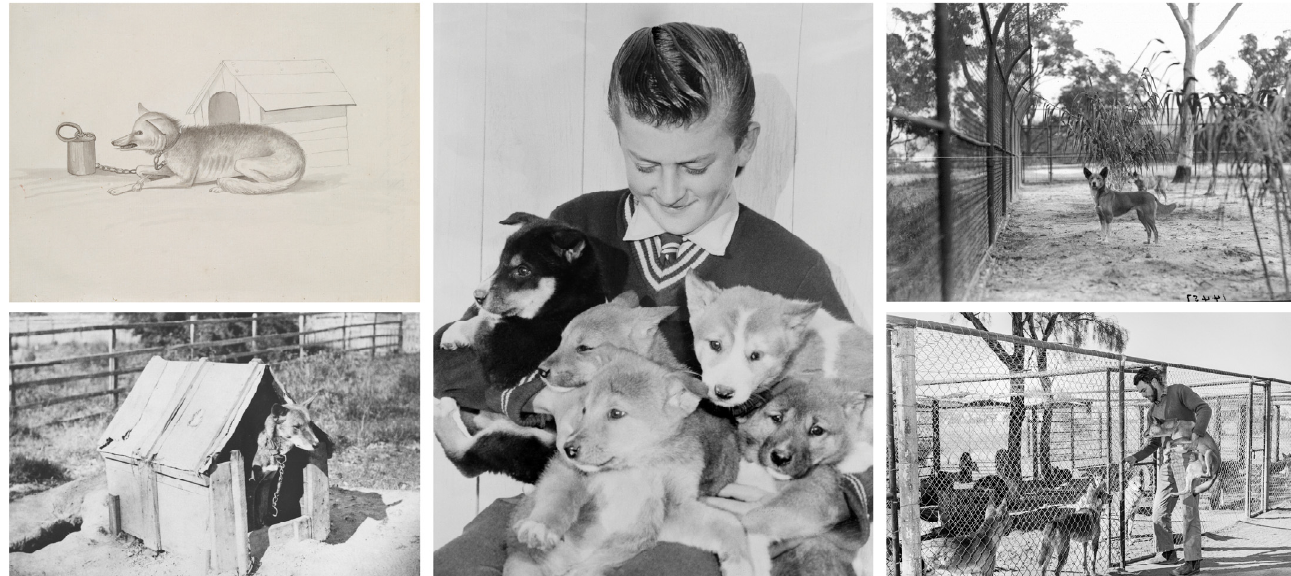
Figure 5. Captive dingoes and dingo pets kept by non-Indigenous Australians, with a focus on the typical restrictions on movement and high-walled enclosures deemed necessary for the keeping of adult dingoes. (Top left): A captive dingo c .1797, presumably obtained by an early European colonist in Sydney (middle): A young boy holds a number of dingo pups he was raising as a pet on his family’s farm in Queensland, 1965; (top right): Dingoes kept in captivity at Taronga Zoo, Sydney, 1930; (bottom right): Dingoes and officer at the Commonwealth Scientific and Industrial Research Organisation (CSIRO) captive dingo colony in Alice Springs, Northern Territory, 1967; (bottom left): Captive dingo kept in kennel at the Acclimatisation Society’s Garden, Brisbane, 1885. Sources: (top left): ‘A wild Dog or Dingo of N. S. Wales’ (Richard Pulteney, 1797): PXA 678/1, Mitchell Library, State Library of New South Wales; (middle): ‘Children’s Newsletter No 29—Ivan Rohlf, a 12 year old schoolboy in Queensland, with five dingo pups he was keeping as pets on his parents’ dairy farm’ (R. Nicol, 1965): National Archives of Australia, A1200 L52197; (top right): ‘Taronga Park Zoo. Dingo (1930): State Archives & Records Authority of New South Wales Government Printing Office 1-2227; (bottom right): ‘Research–Zoology–CSIRO experimental officer measures a dingo in NT dingo research’ (Australian News and Information Bureau, 1967): National Archives of Australia, A1200 L64195; (top left): ‘Captive dingo at the Acclatisation [sic] Society’s Garden, Brisbane’ (Francis Hall, 1885): State Library of Queensland.